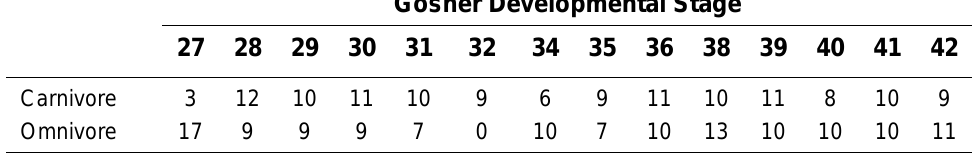
Number of Carnivores and Omnivores at Each Gosner Developmental Stage Measured for Analyses Gosner Developmental Stage 27